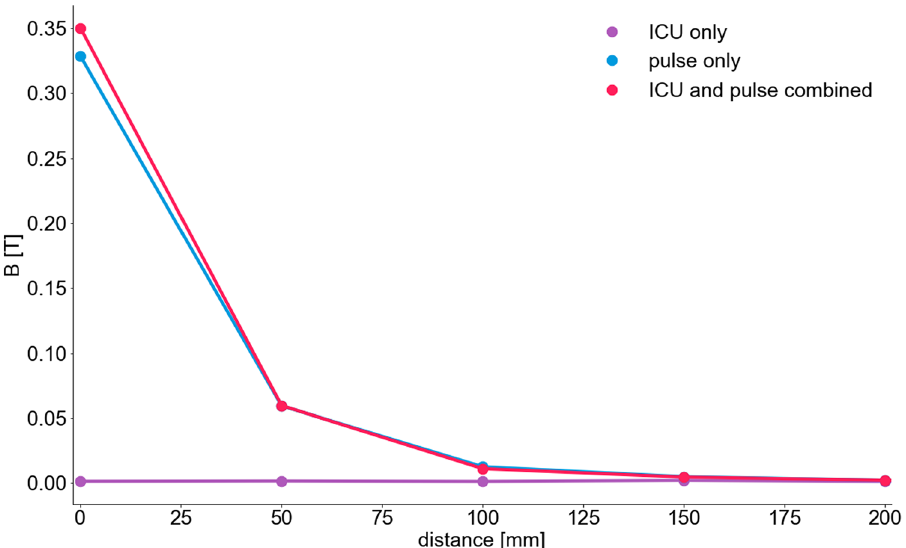
Figure 3. Magnetic flux density in ICU setting at different test points. Measurement of the magnetic flux density was done at different test points in the ICU with only ICU equipment switched on, only stimulator switched on and ICU and stimulator switch on at the same time. Points are connected with lines for visual guidance. B magnetic flux density